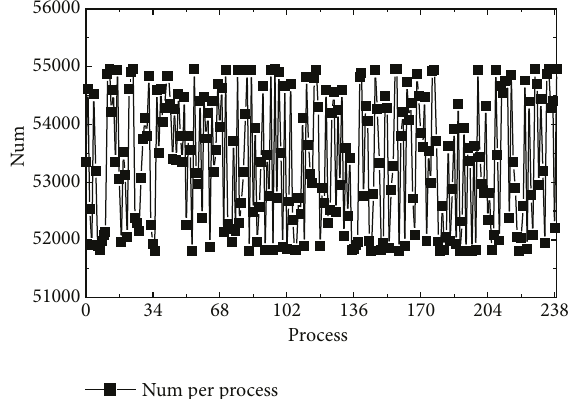
Figure 13: Number of tetrahedrons per